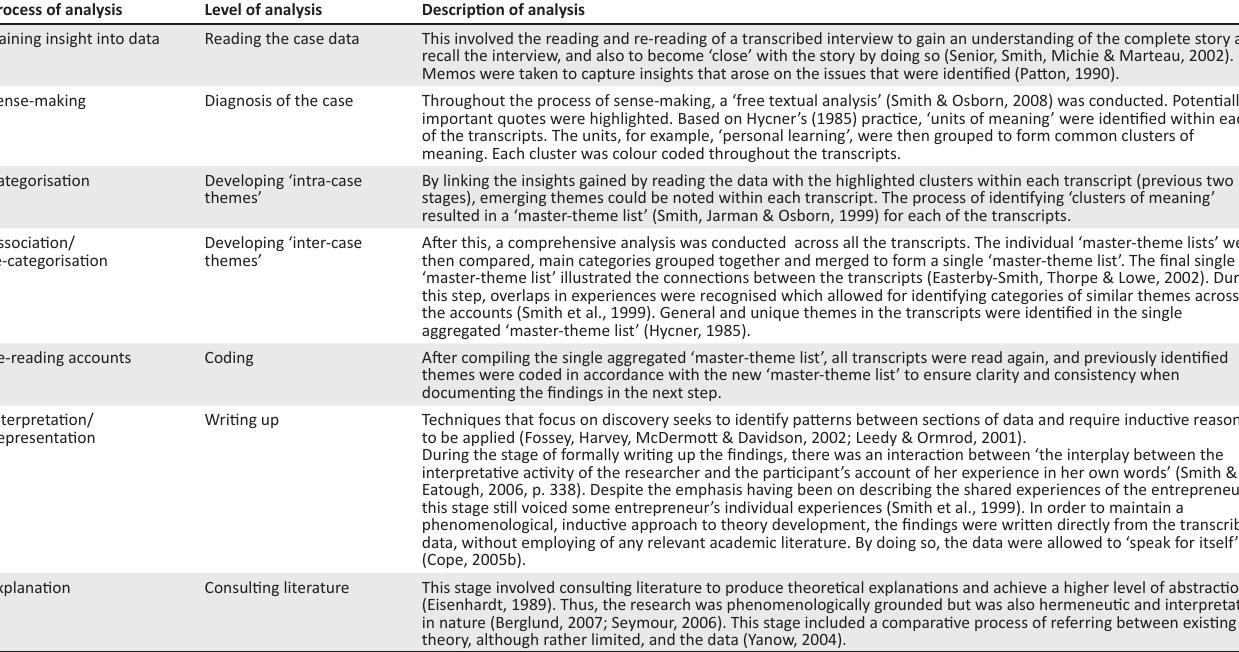
TABLE 4: Levels of interpretative phenomenological analysis used to extract insights from